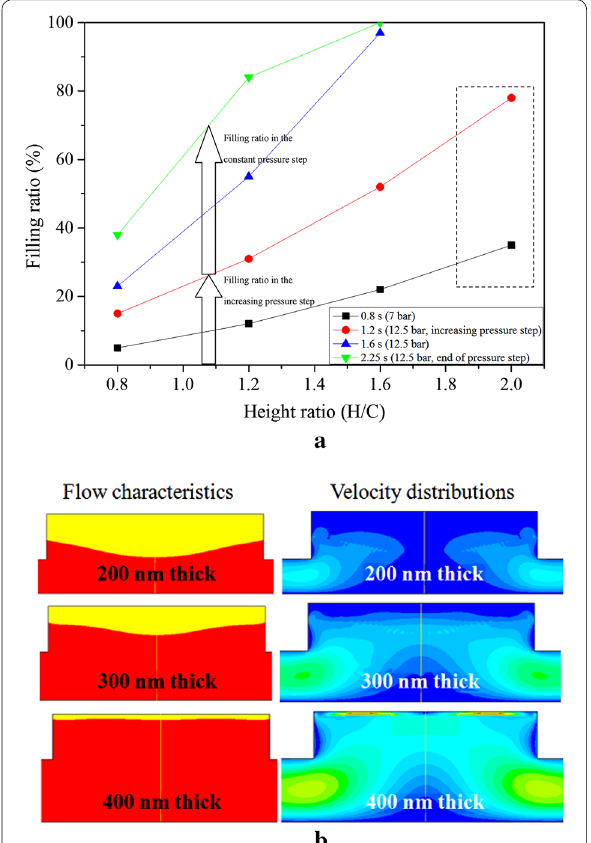
Fig. 6 Variations of the a filling ratio with height ratios and b flow characteristics and velocity fields according to the polymer thickness. (Temperature 438 K; pressure variation rate = step 1.6 s) =